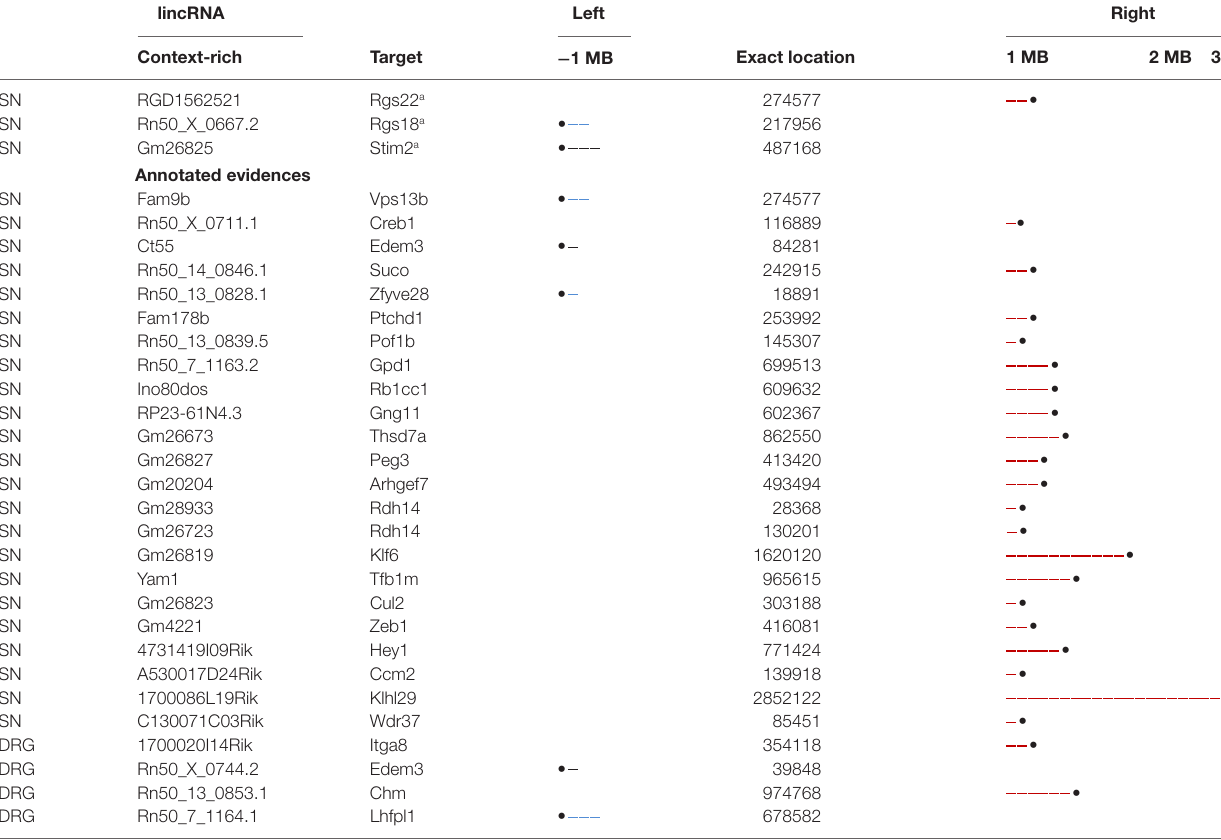
Rn50_7_1164.1 678582